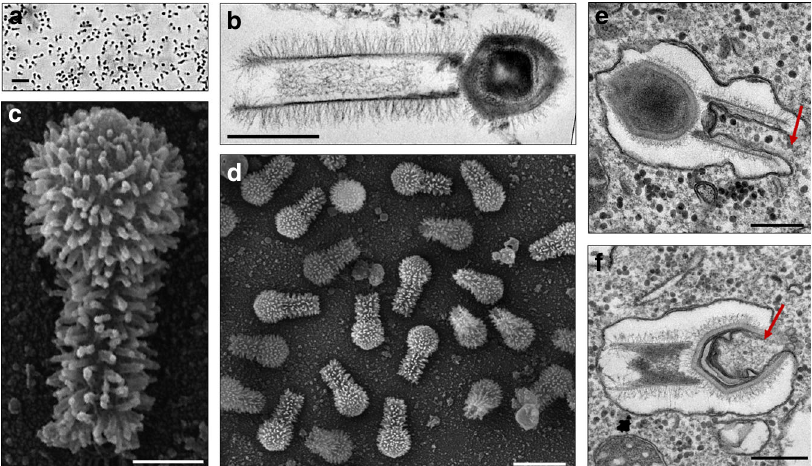
Fig. 1 Tupanvirus soda lake particles and cycle. a Optical microscopy of Tupanvirus particles after haemacolour staining (1000 × ). Scale bar, 2 µ m. b Super particle (>1000 nm) observed by transmission electron microscopy (TEM). Scale bar, 500 nm. c , d Scanning electron microscopy (SEM) of Tupanvirus particles. Scale bars 250 nm and 1 µ m, respectively. e , f The initial steps of infection in A . castellanii involve the release of both capsid ( e ) and tail ( f ) content into the amoeba cytoplasm (red arrows). Scale bars, 350 nm and 450 nm,